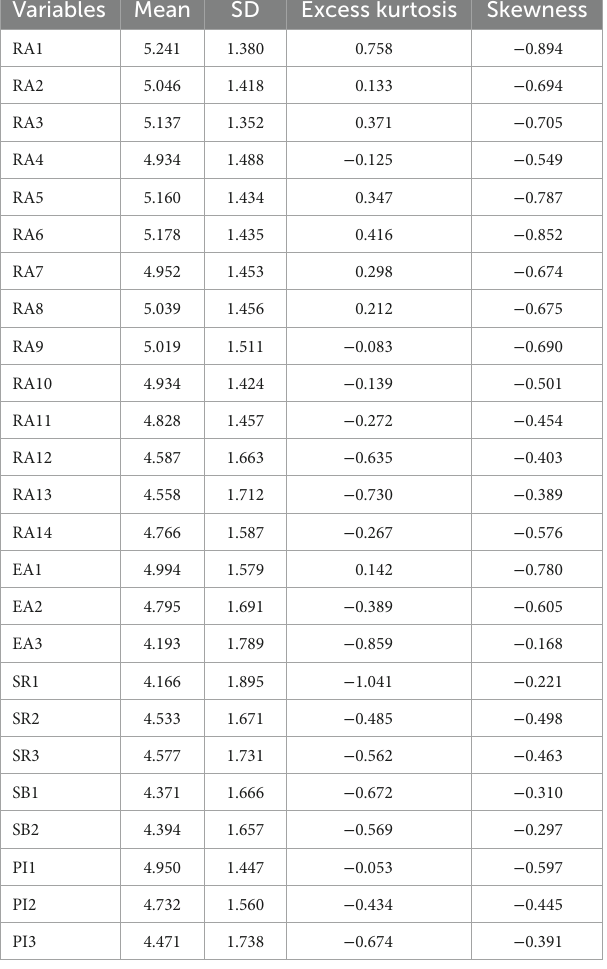
TABLE 2 Mean, SD, excess kurtosis, and